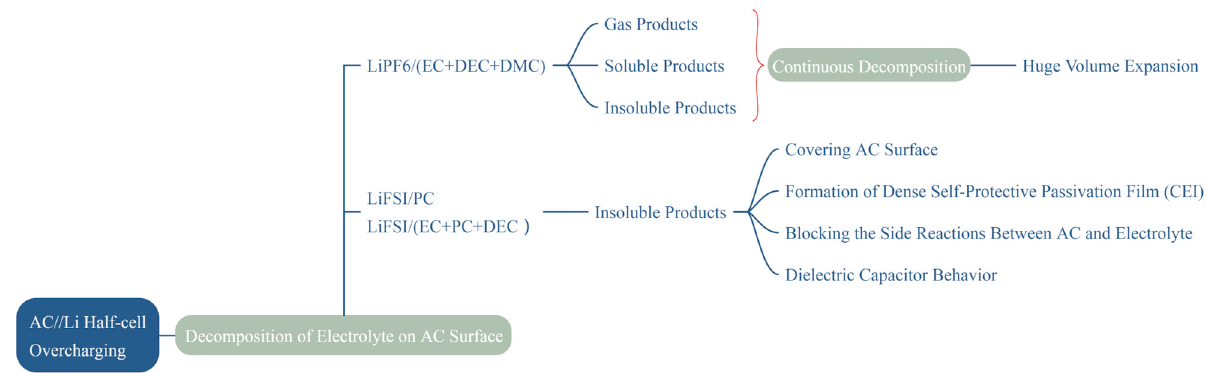
Figure 8. Schematic diagram of the decomposition of electrolyte on AC surface upon overcharging.